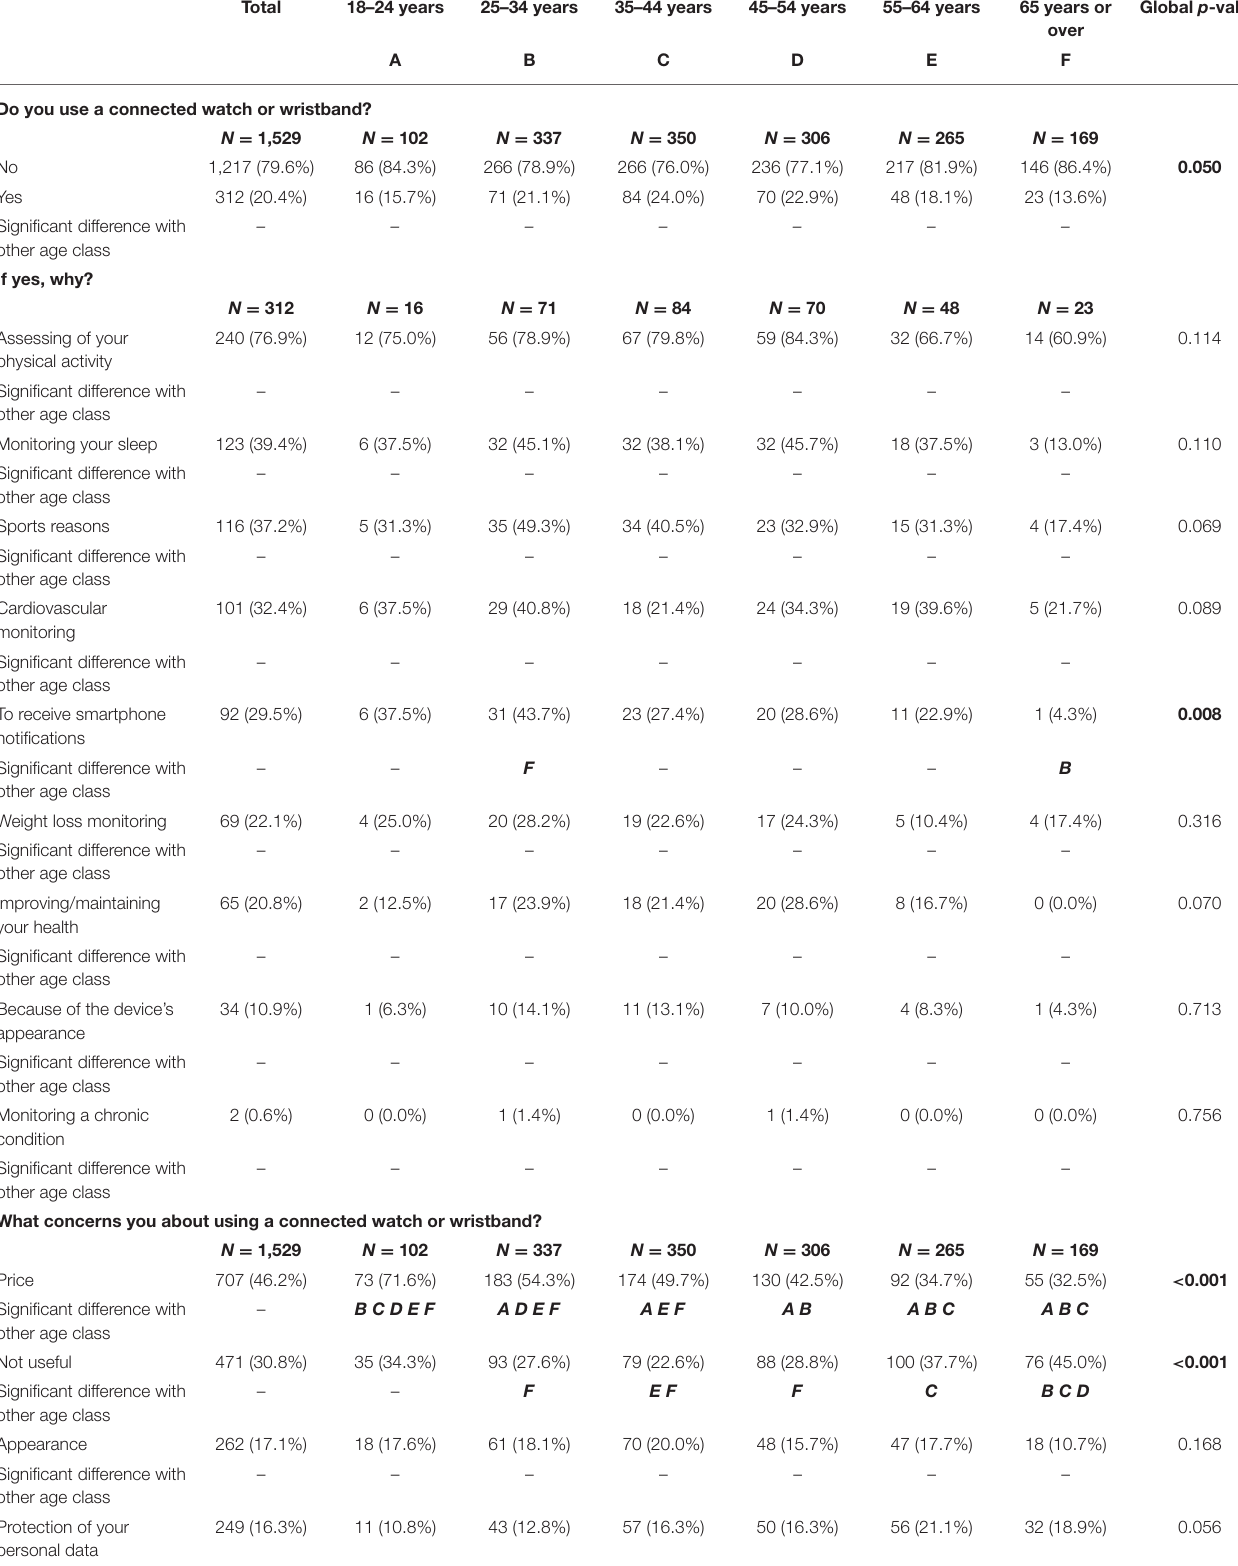
TABLE 4 | Connected watch/wristband use, expectations and concerns by age